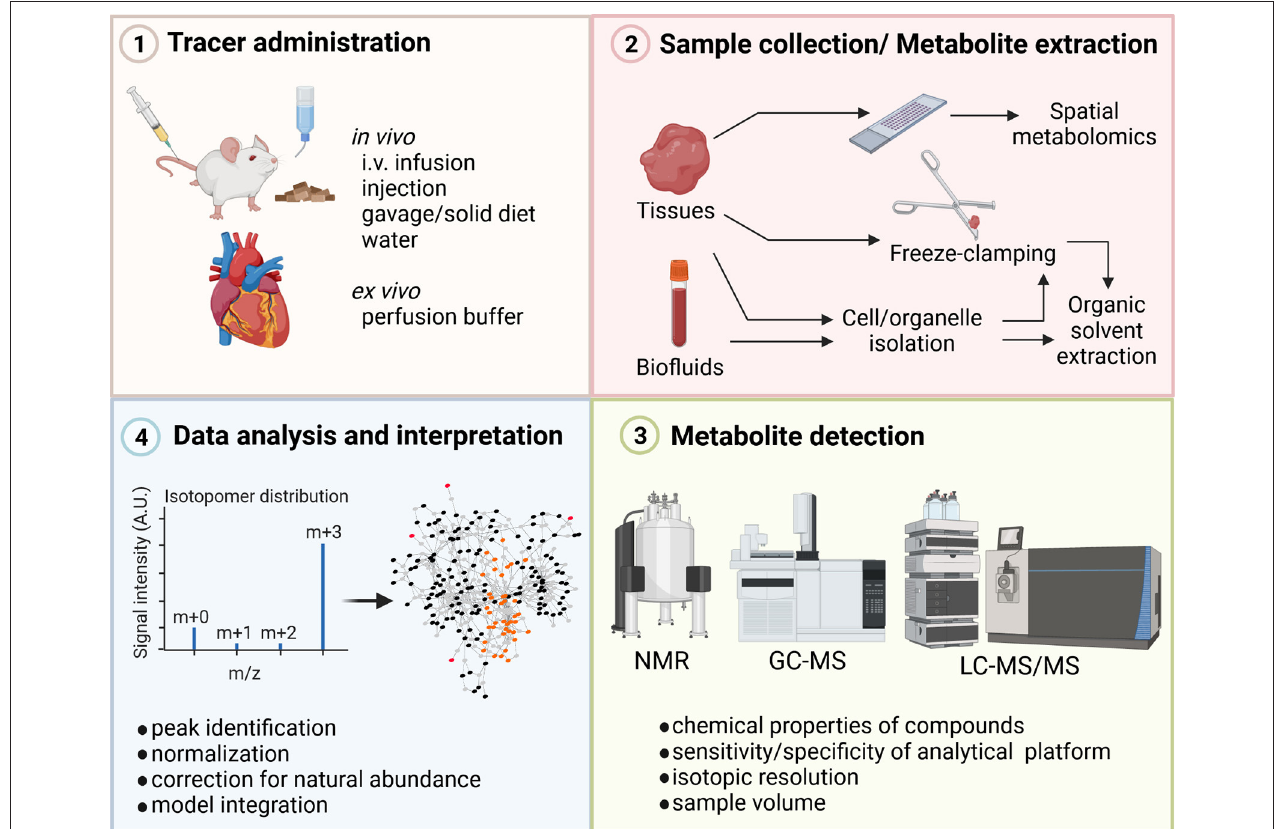
FIGURE 1 | Steps in stable-isotope metabolomics analysis. Stable-isotope tracers to study cardiac metabolism are administered to the model organism or patient using different delivery approaches including, infusion, injections, diet, or ex vivo perfusion. Heart tissue or biofluids are collected and metabolites are extracted based on downstream analytical methods. For examples, tissue sample for total metabolite extraction are freeze-clamped in liquid nitrogen and tissue is quenched during extraction using organic solvents. To assess spatial metabolite abundances, tissue slides need to be prepared. Incorporation of isotopic label into metabolites is determined using analytical techniques such as NMR or MS. The isotopic enrichment profile of different metabolites is assessed after normalization and correction for natural abundances. GC, gas chromatography; i.v., intravenous; LC, liquid chromatography, MS, mass spectrometry; NMR, Nuclear magnetic resonance. Figure was created with